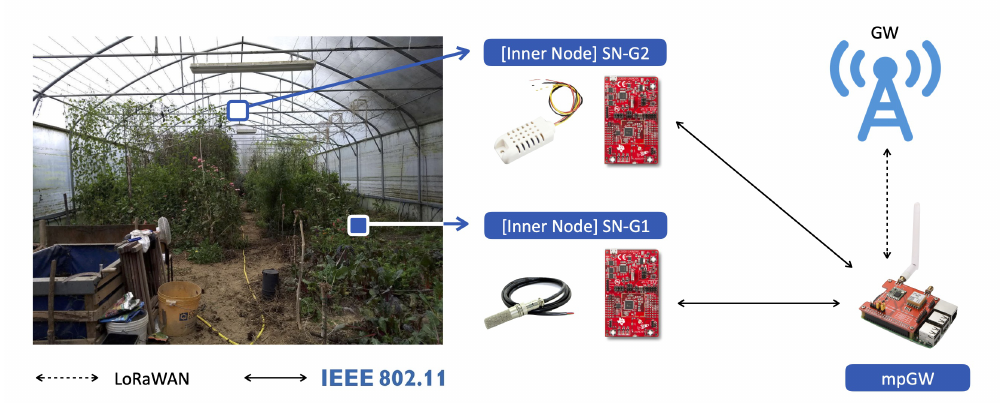
Figure 8. The greenhouse module: INs and mpGW with corresponding locations in the greenhouse.